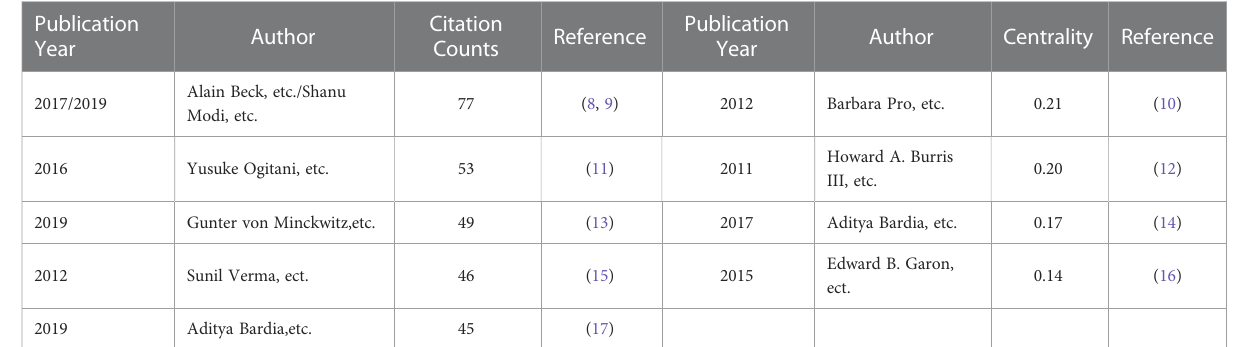
TABLE 4 The top 5 co-cited references involved in